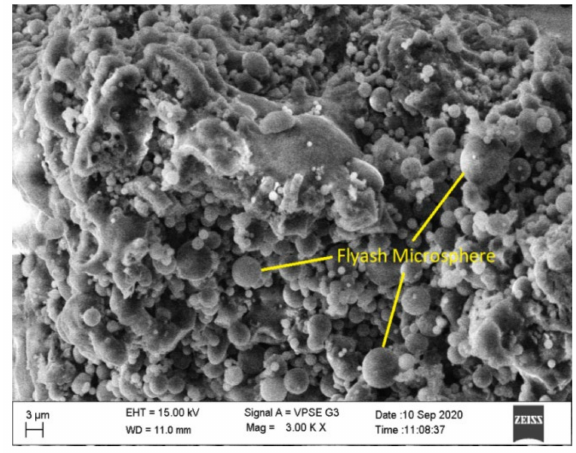
Figure 10. SEM image of fly ash.